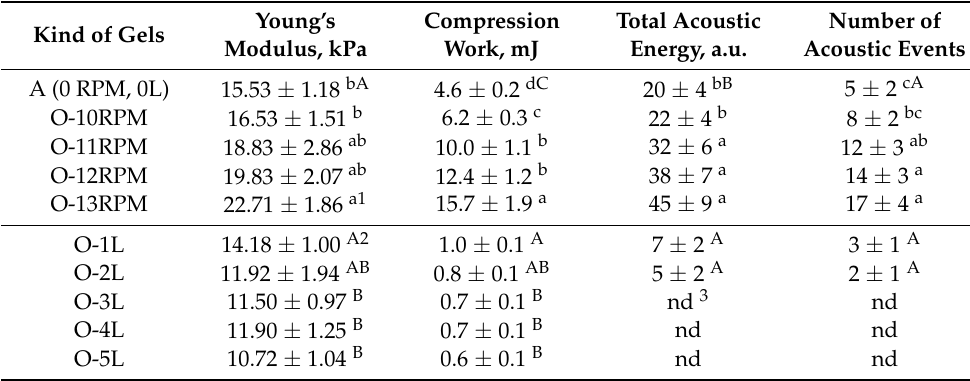
Table 3. Selected mechanical and acoustic descriptors of gels. Kind of Gels